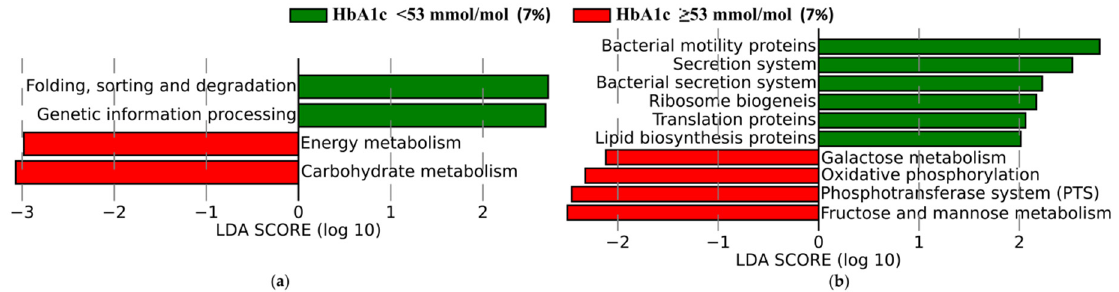
Figure 5. Functional divergence between the faecal microbiota of patients with type 1 diabetes and glycosylated hemoglobin (HbA1c) < 53 mmol/mol (7%) and ≥ 53 mmol/mol (7%). The comparisons of pathways at level 2 (phylum) ( a ) and level 3 (class) ( b ) were performed based on Kyoto Encyclopedia of Genes and Genomes.